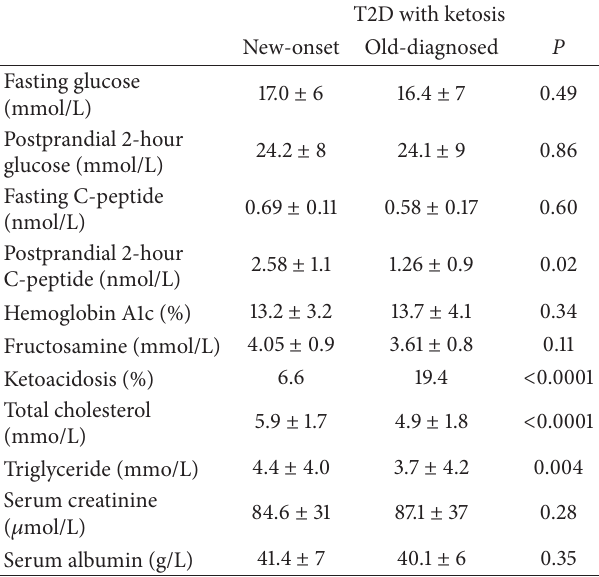
Table 2: Laboratory results of the new-onset and old-diagnosed T2D with ketosis